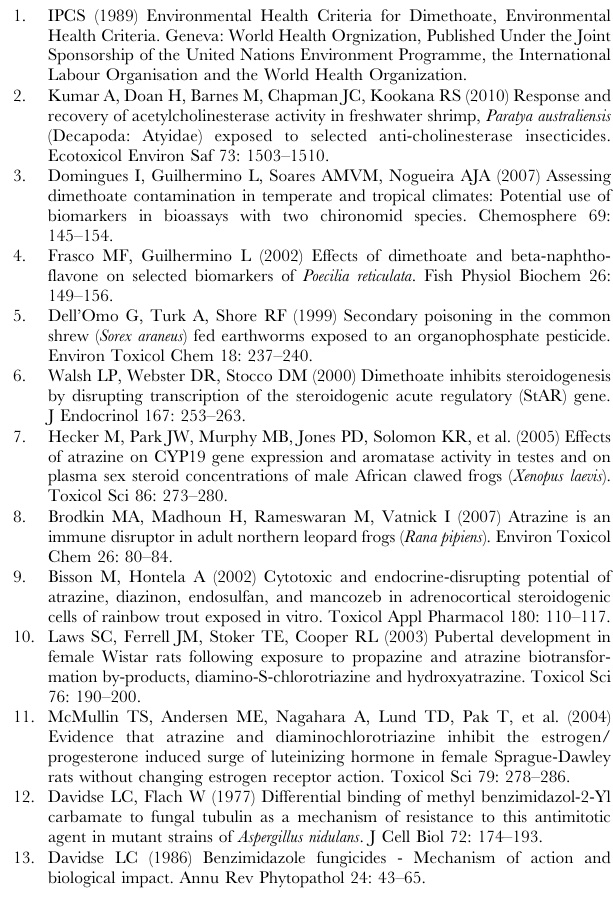
Figure S1 Correlation between gene expressions measured in Enchytraeus albidus using microarray analysis and qPCR. Each point represents the expression of a gene in one of the exposure conditions to dimethoate, atrazine or carbendazim. Table S1 Gene expression validation with quantitative Real Time PCR in Enchytraeus albidus when exposed to dimethoate, atrazine or carbendazim using reproduc- tion EC10, EC20, EC50 and EC90. Table S2 Significant differentially expressed tran- scripts (two sample t-test, p , 0.05) in Enchytraeus albidus when exposed to four concentrations of dimeth- oate, atrazine and carbendazim (reproduction EC10, EC20, EC50 and EC90). Table S3 Significant enriched GO terms (p , 0.05) in Enchytraeus albidus in the following lists of differen- tially expressed genes: 1) uniquely affected by dimethoate; 2) uniquely affected by atrazine; 3) uniquely affected by carbenda- zim; 4) affected by dimethoate and atrazine; 5) affected by